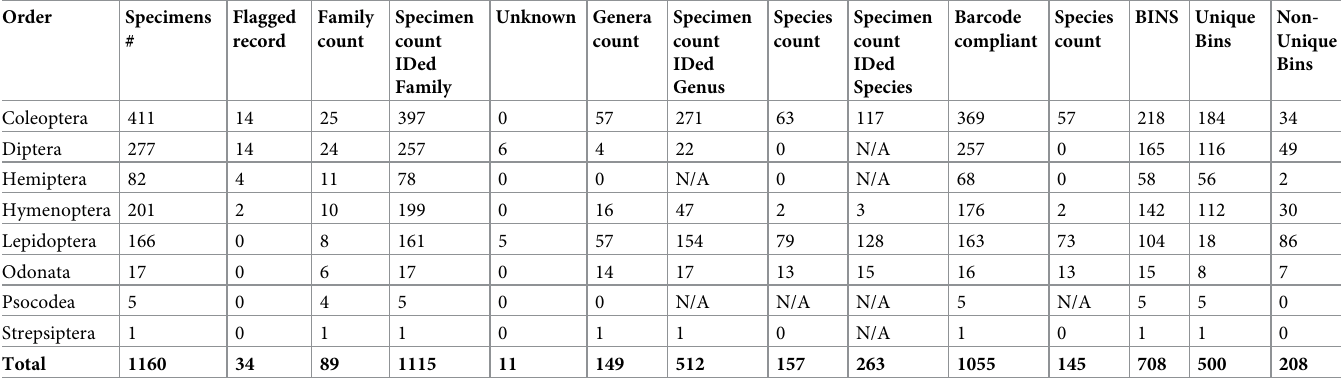
Table 2. Summary of specimens and barcodes data by orders after removal of flagged records.